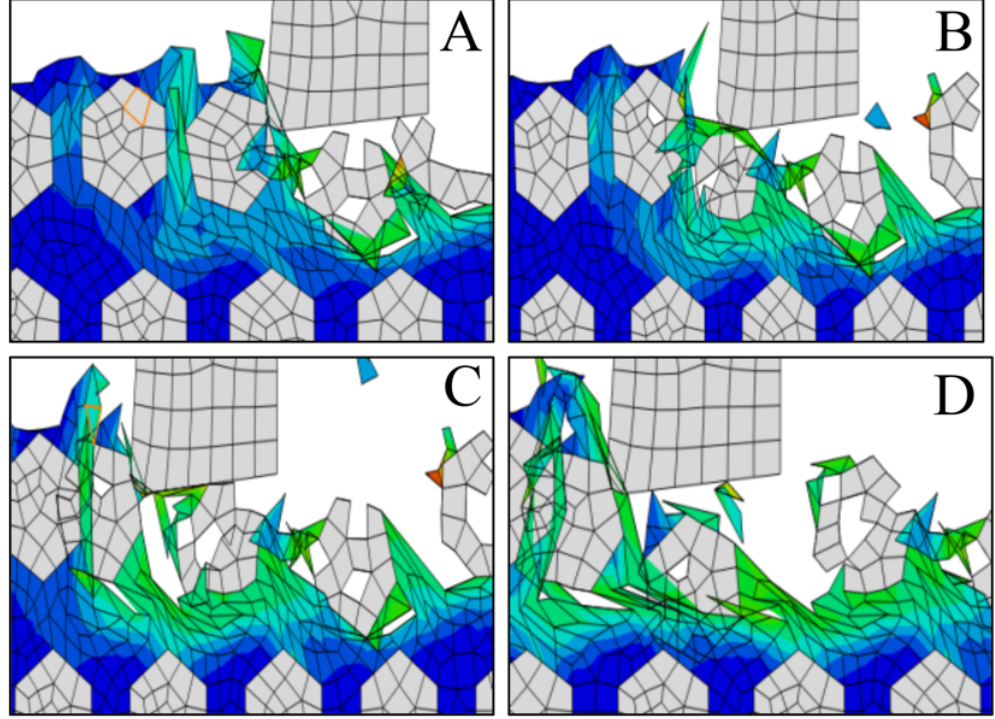
Figure 26. ( A – D ) Formation process of a machined surface bulge.